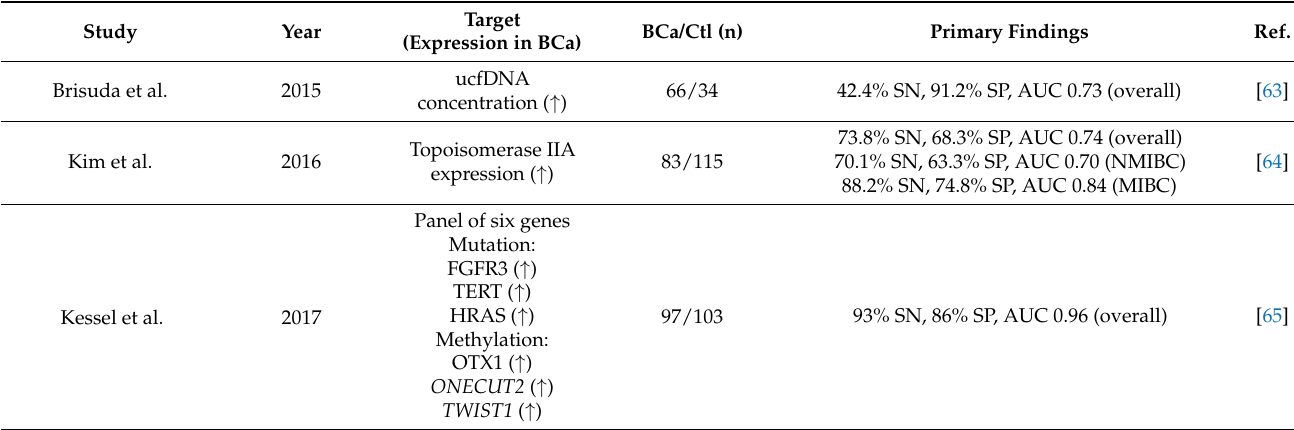
Table 2. Diagnostic accuracy of urinary cell-free DNA (ucfDNA) for bladder cancer